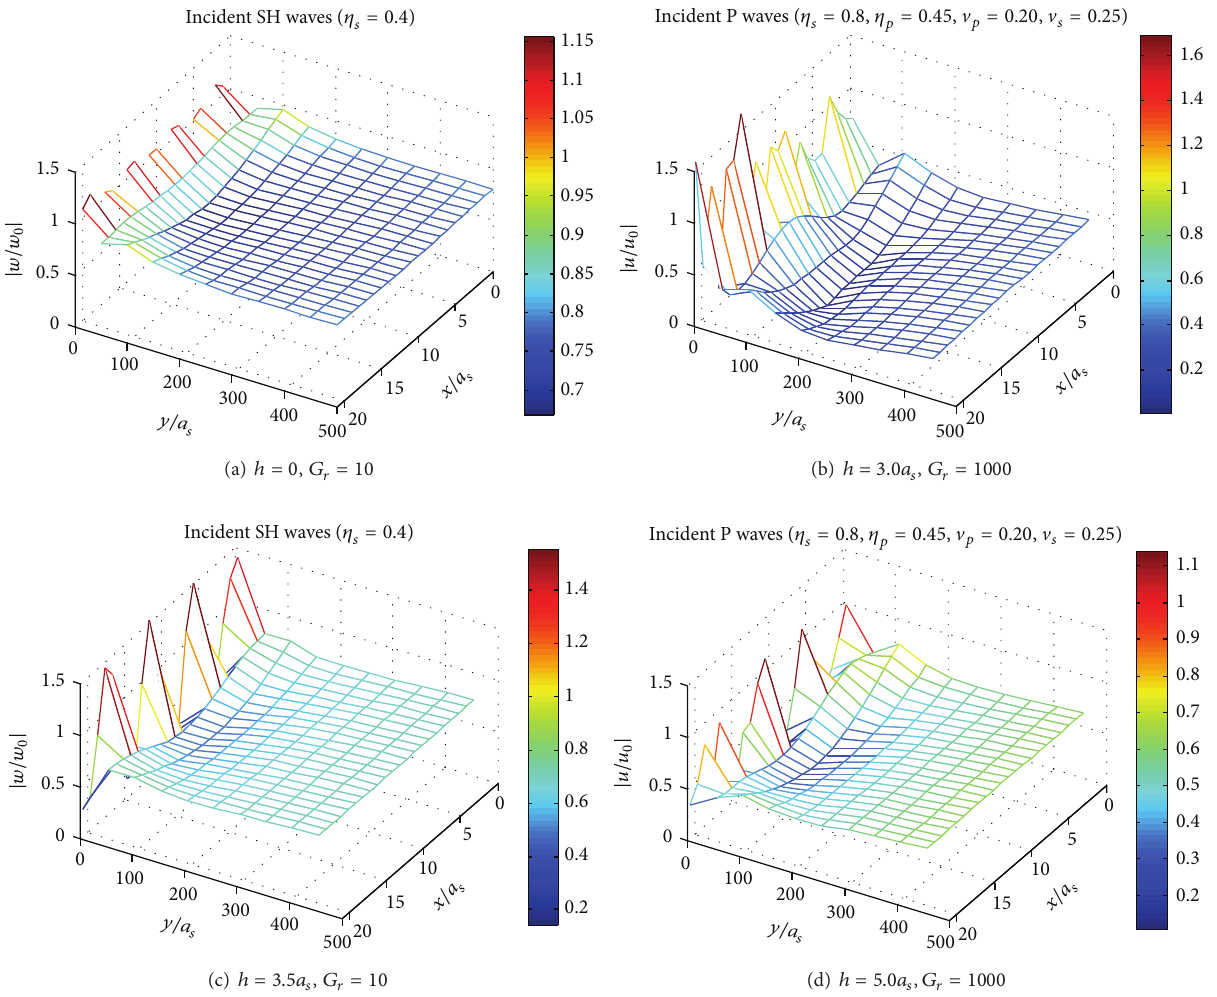
Figure 9: Normalized displacement amplitudes meshes behind the isolation system under different row-separations of tubular piles ( 𝑏 𝑠 = 𝑠 = 3.0𝑎 𝑚 = 4 , 𝑁 = 8 0.9𝑎 𝑠 , 𝑝 𝑠 ,